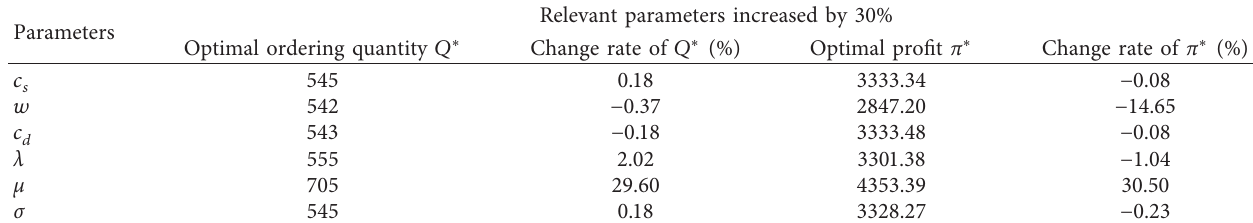
Table 2: The parameters’ influence on the optimal ordering quantity and profit without RFID. Parameters